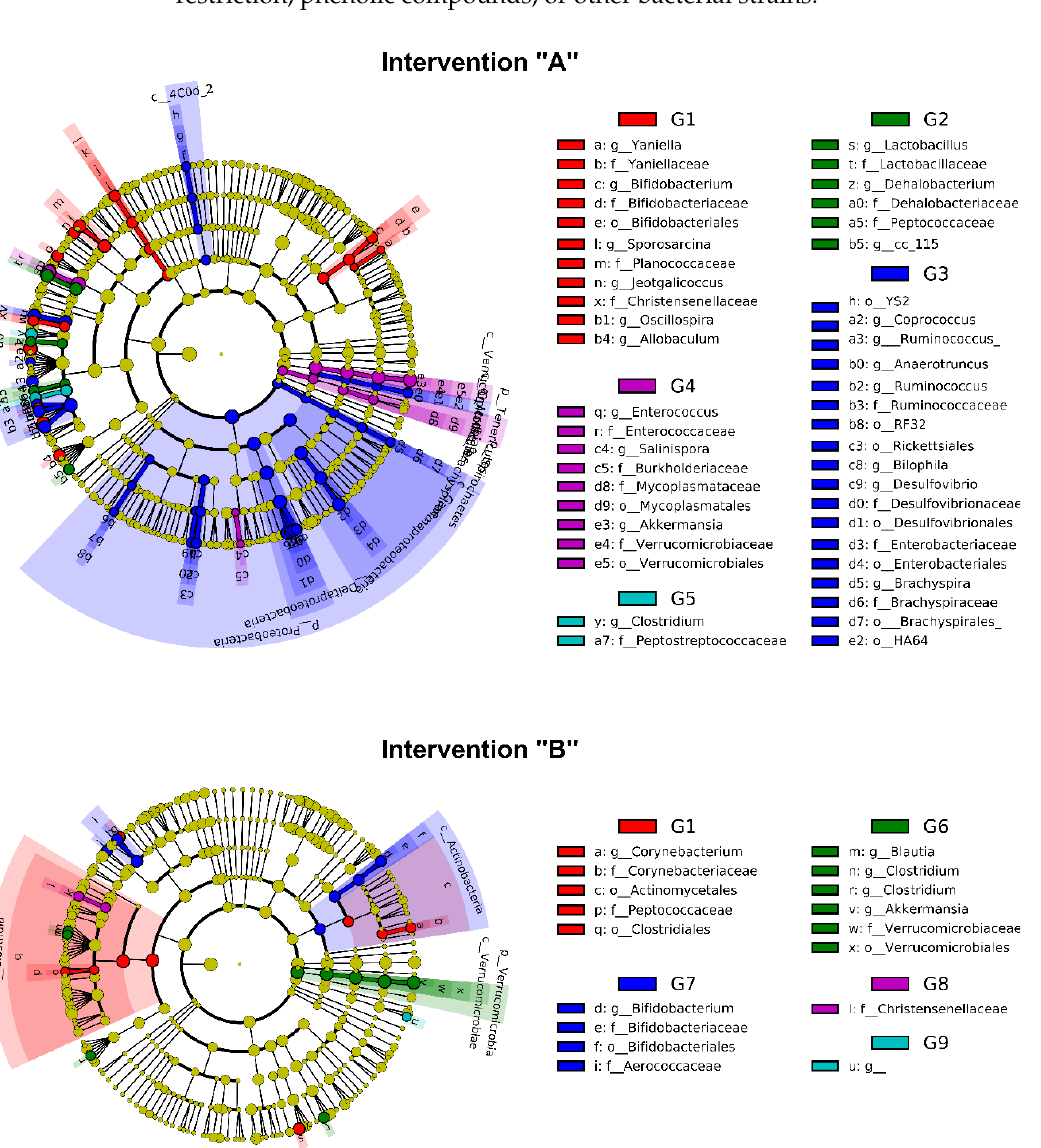
Figure 3. Linear discriminant analysis effect size (LEfSe) analysis. G1: negative control group, G2: high fat diet (HFD), G3: LG-G12 HFD, G4: cefriatoxane HFD, G5: cefriatoxane + LG-G12 HFD, G6: standard fat diet (SFD), G7: LG-G12 SFD, G8: cefriatoxane SFD, G9: cefriatoxane + LG-G12 SFD. Only taxonomic groups showing linear discriminant analysis (LDA) scores > 2.0 with false discovery rate (FDR) p < 0.05 are shown. Letters: p, phylum; c, class; o, order; f, family; g, genus. This analysis was carried out to identify significant differences in abundant taxa (fecal biomarkers) after interventions “A” and